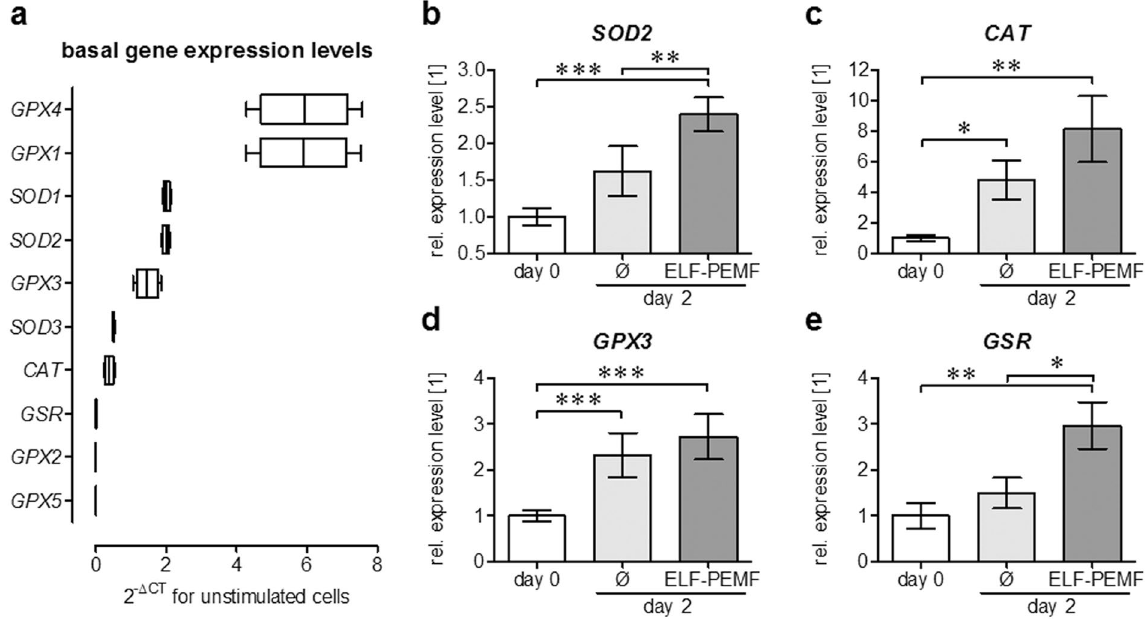
Figure 3. ELF-PEMF exposure induces gene expression of intracellular antioxidative enzymes in hOBs. ( a ) Basal expression levels of oxidative stress ( • O 2 − and H 2 O 2 ) related genes in hOBs was determined using the RT² Profiler PCR Array human oxidative stress plus (Qiagen, Hilden, Germany). ( b – e ) Semi-quantitative RT-PCR revealed that expression of SOD2, CAT, GPX3 and GSR was increased by repetitive exposures to ELF-PEMF (7 min per day) during the osteogenic differentiation of hOBs. Densitometric analysis (ImageJ software) was performed with individual samples (N = 12) analyzed twice (n = 2) to reduce small loading differences. The mean signal intensity of cells on day 0 was set as reference. * p < 0.05, ** p < 0.01 and *** p < 0.001 as indicated (Kruskal-Wallis test followed by Dunn’s multiple comparison test, α =